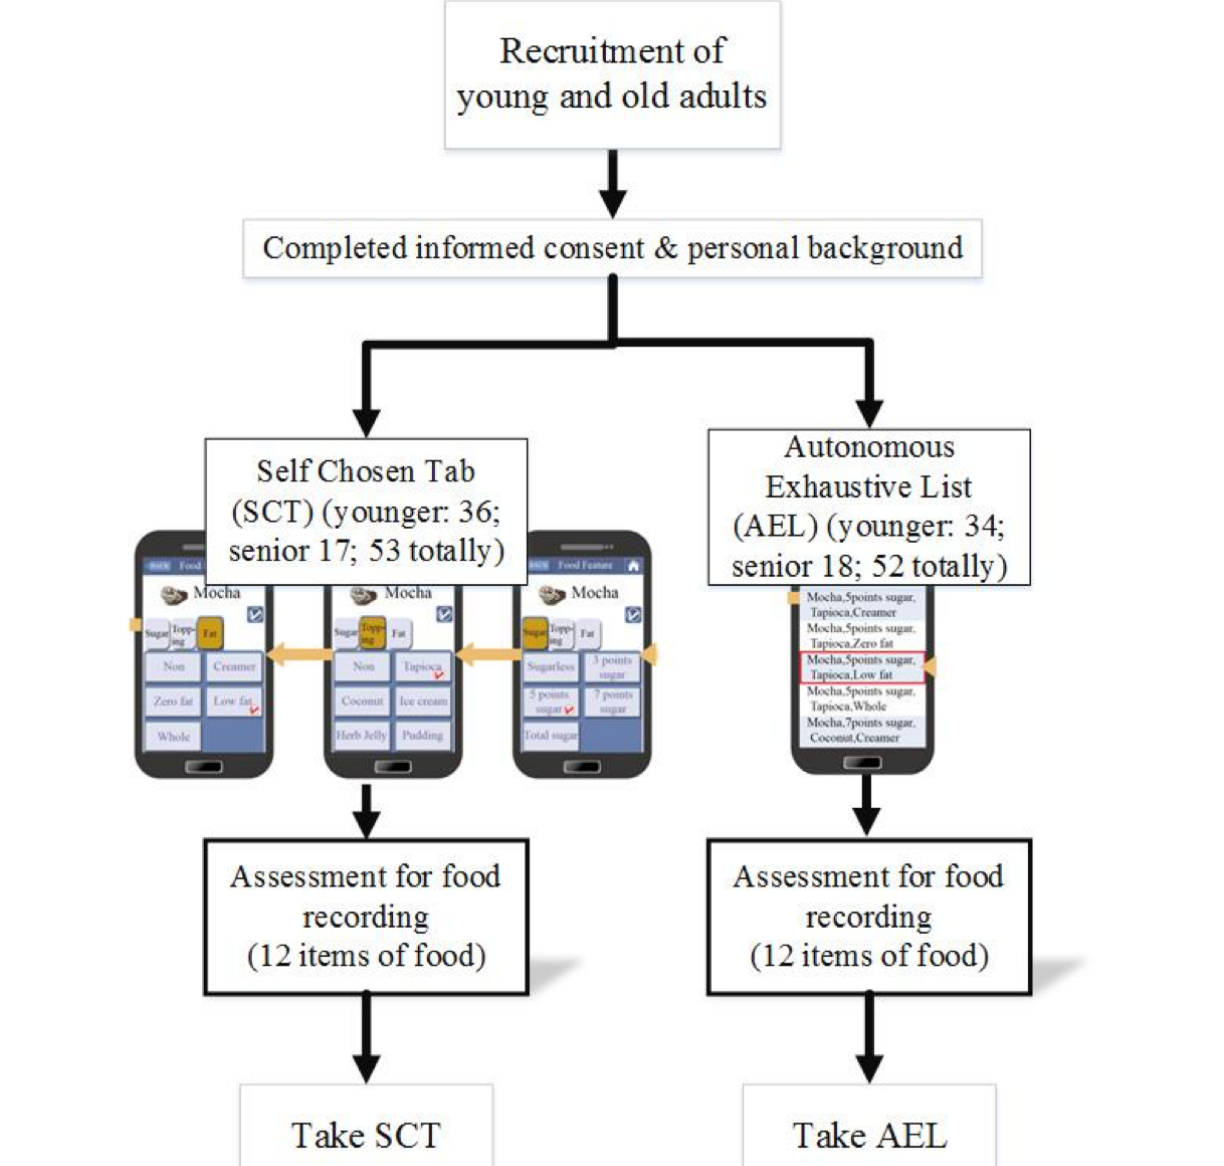
Figure 3. App evaluation flow using randomized